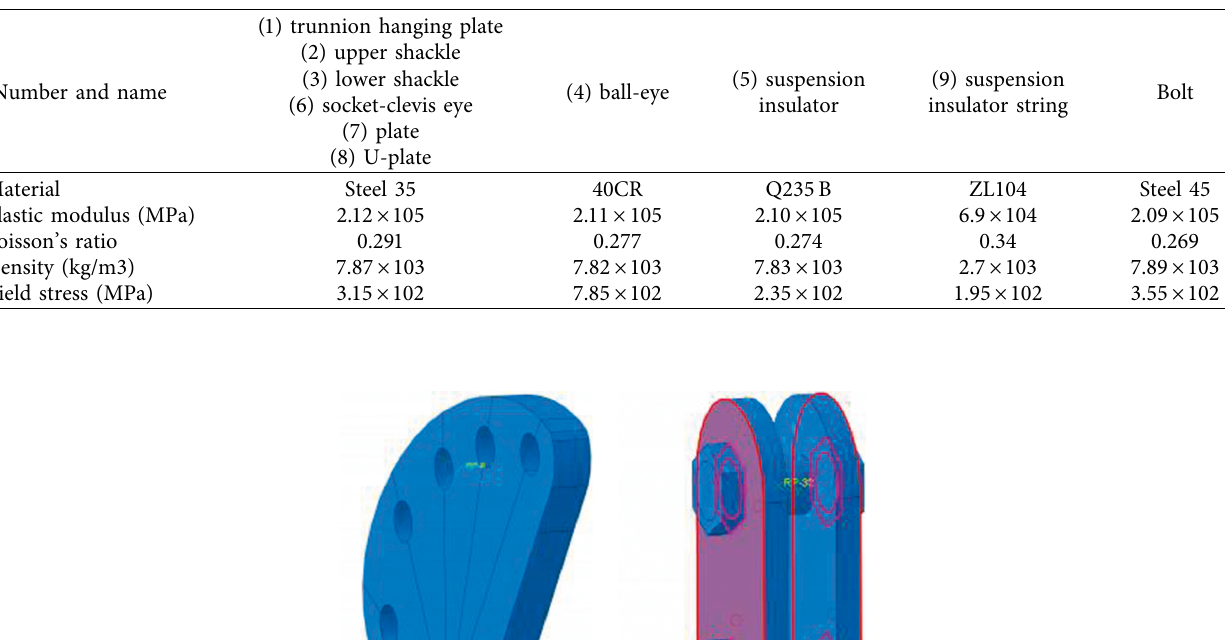
Table 9: Material parameters of suspension string parts.